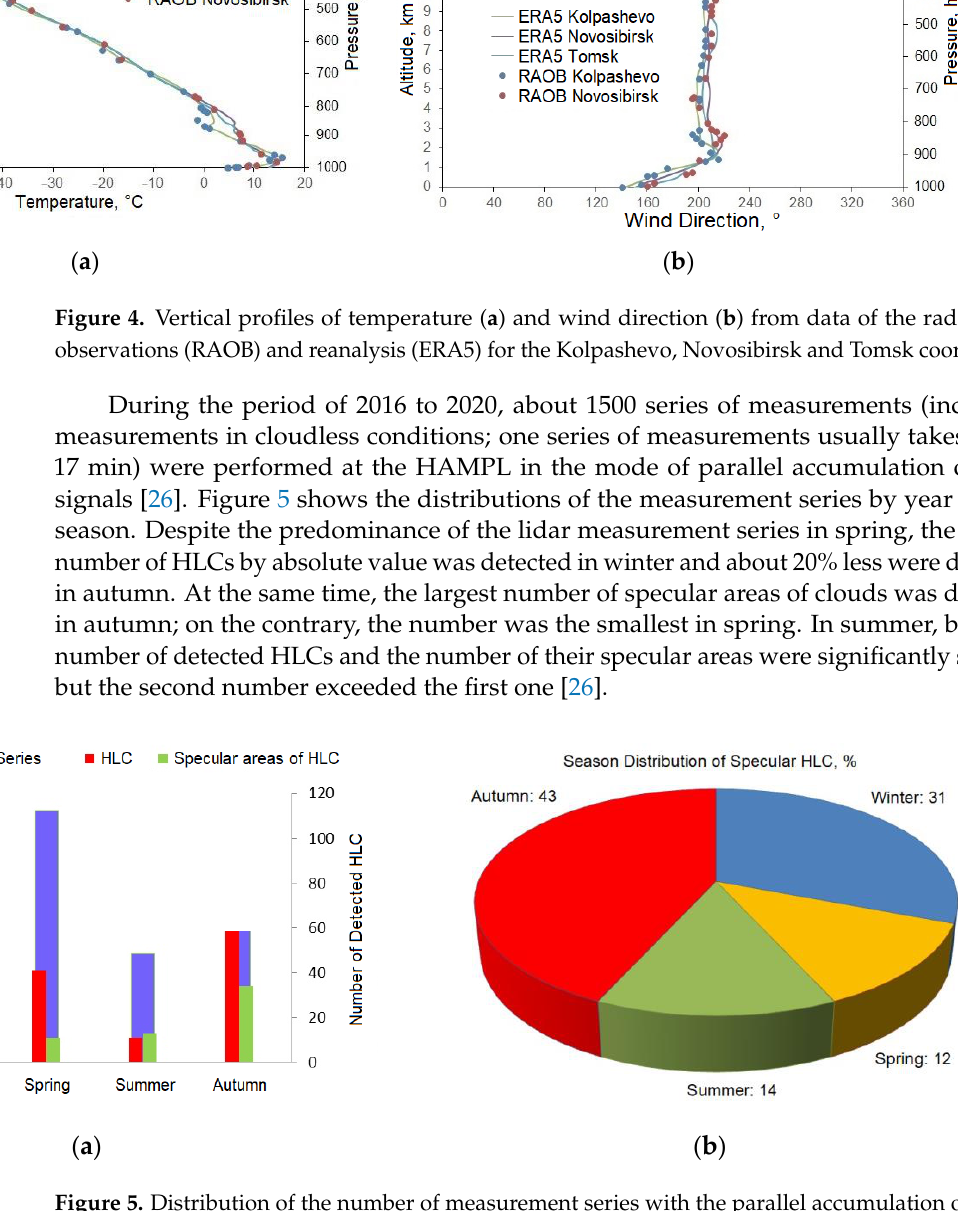
Figure 5. Distribution of the number of measurement series with the parallel accumulation of photoelectron pulses at the HAMPL ( a ) and specular HLCs registered with it ( b ) by season (2016– 2020).